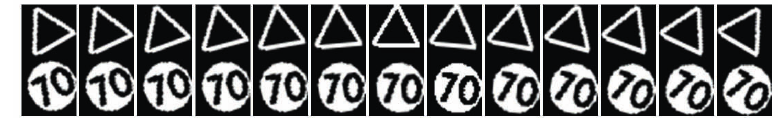
Figure 9. Rotated signs from (cid:0) 30 (extreme left) to C 30 (extreme right).